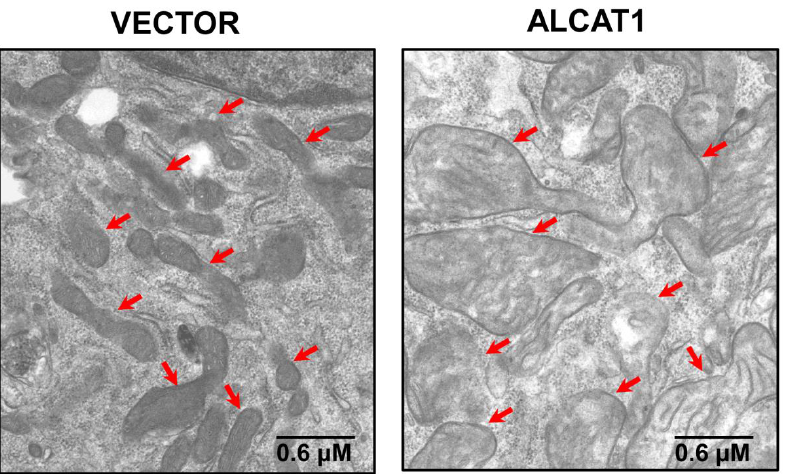
Figure 4. Overexpression of ALCAT1 causes mitochondrial swelling and loss of cristae structure. Electron microscopic analysis of mitochondrial morphology in C2C12 skeletal myocytes cells with stable expression of vector control or ALCAT1 with mitochondria highlighted by arrows. stable expression of vector control or ALCAT1 with mitochondria highlighted by